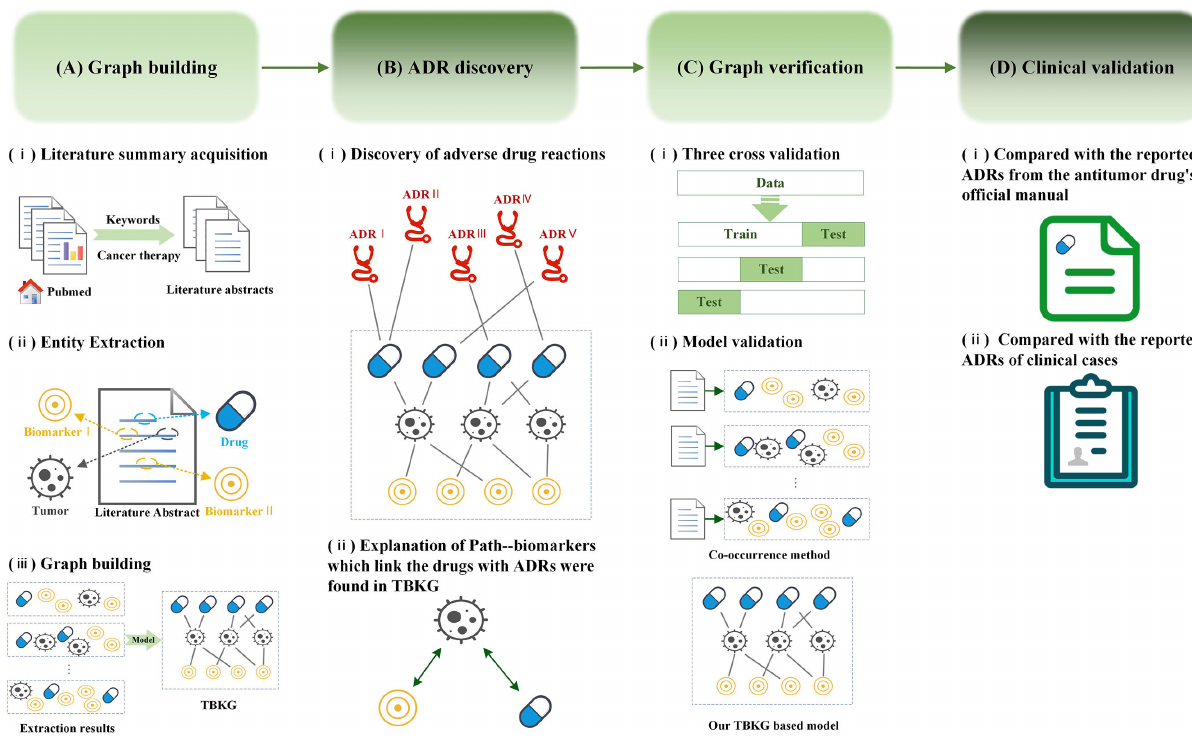
FIGURE 1 | Workflow for adverse drug reaction discovery using the Tumor-Biomarker Knowledge Graph (TBKG). (A) The construction process of TBKG. (B) The results of ADR discovery based on TBKG. (C) Preclinical verification of the ADR discovery based on TBKG. (D) Clinical validation of the ADR discovery based on